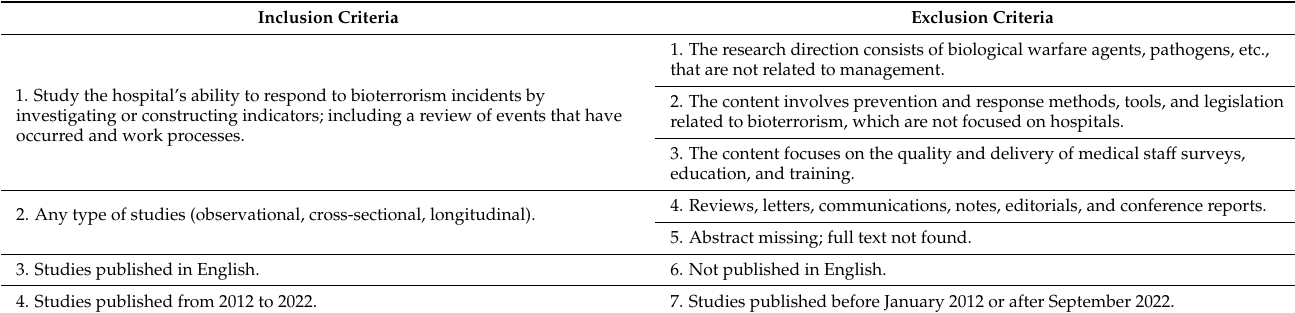
Table 2. Inclusion of exclusion